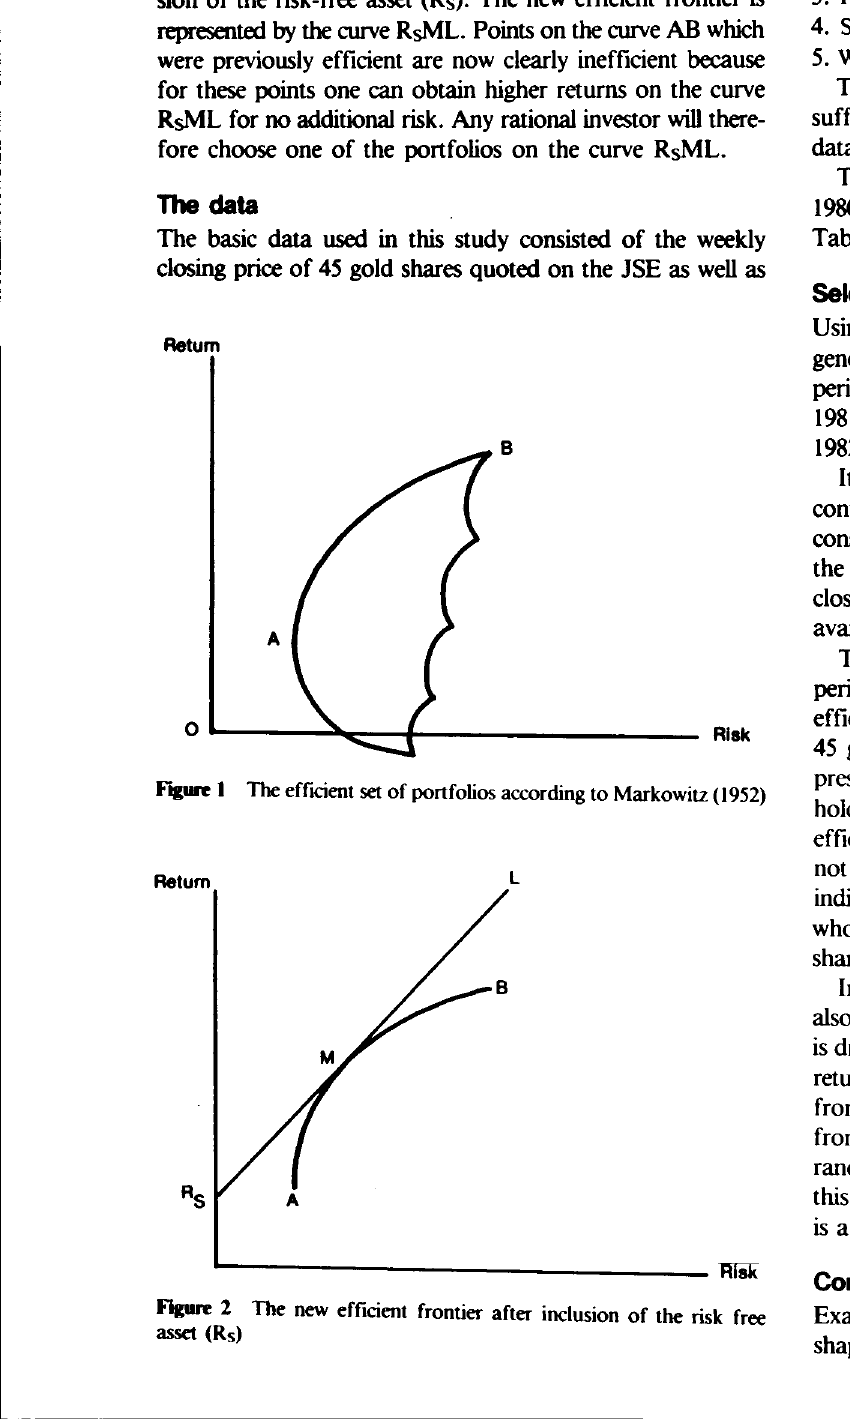
Figure 2 The new efficient frontier after inclusion of the risk free asset